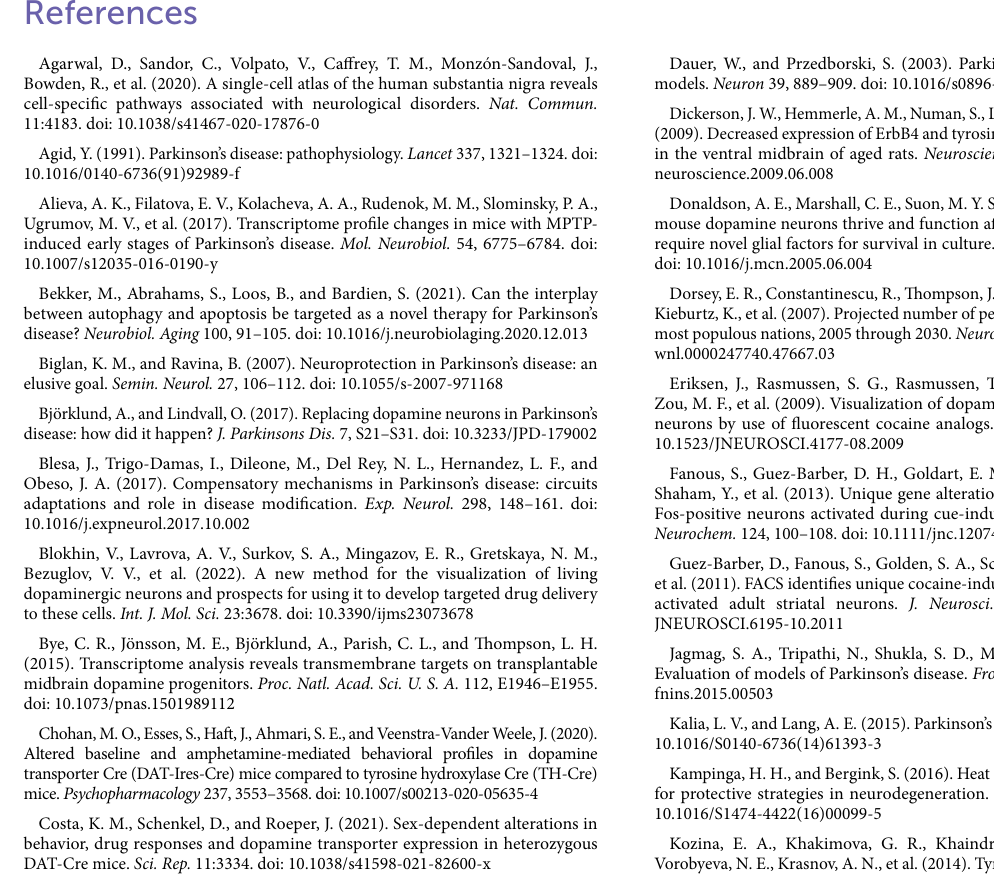
SUPPLEMENTARY FIGURE 8 The number of sorted dopaminergic neurons in mice two weeks after 4-fold administration of 1-methyl-4-phenyl-1,2,3,6-tetrahydropyridine (MPTP) in a single dose of 12 mg/kg, or saline in control. Groups were compared for normality by using the D’Agostino & Pearson test. Statistics indicate significance by the unpaired t-test (* P < 0.05 compared with the control group). Data are presented as mean ± SEM. n = 9 for each